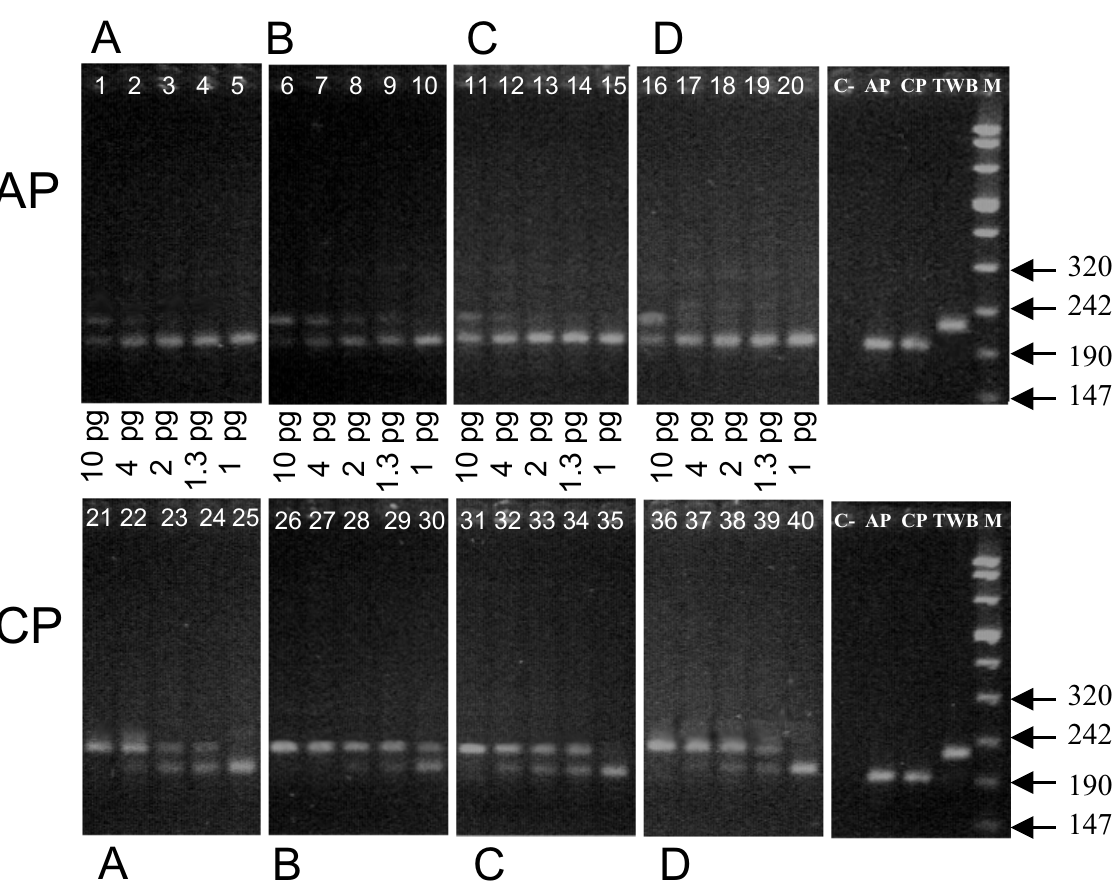
Fig. 2. Gel electrophoresis of the competitive PCR amplification products obtained with the second series of the DNA extractions. The DNA obtained with the four extraction techniques from plants infected with AP-phytoplasma (top: method A, lanes 1–5; B, lanes 6–10; C, lanes 11–15; D, lanes 16–20) and CP-phytoplasma (bottom: method A, lanes 1–5; B, lanes 6–10; C, lanes 11–15; D, lanes 16–20) was amplified in the presence of serial dilutions of competitor DNA. The dilutions of the competitor DNA are shown and expressed as pg. Lane C-: negative control. Lanes AP, CP, TWB: positive control for AP, CP and TWB phytoplasma DNA. Lane M: molecular size Marker VIII (Roche diagnos- tic, Mannheim,